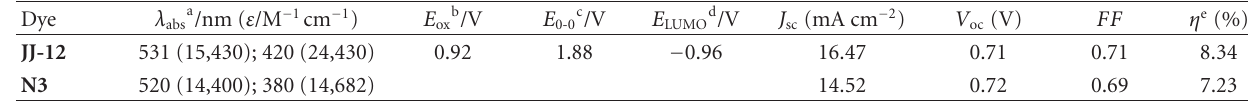
Table 1: Optical, oxidation, and DSSC performance parameters of dyes.